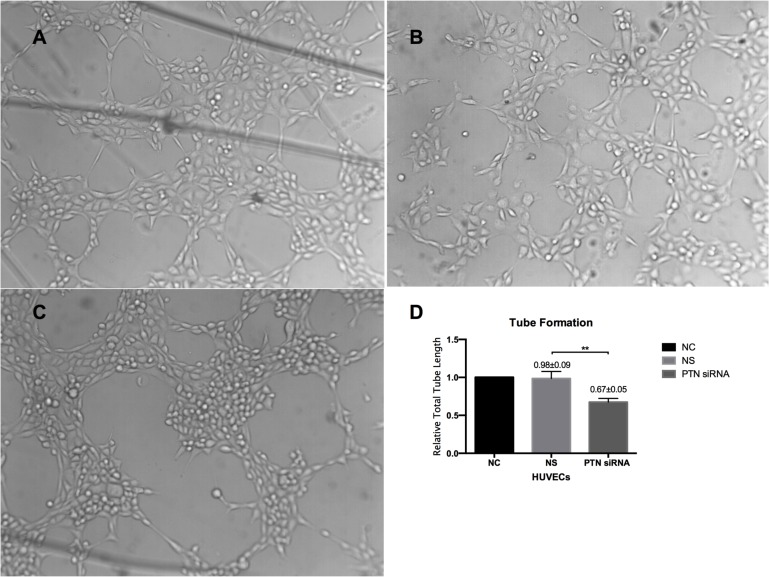
Effects of PTN on HUVEC tube formation.Microphotographs are representative of tube-like structure generation after a 4-h incubation on Matrigel. The length of tube branches per view field was measured. PTN-siRNA-treated HUVECs (panel C) showed an impaired capacity to form a regular vascular network. The length of the angiogenesis network was statistically significantly decreased compared to the control groups. Each experiment was repeated at least three separate times. Data are presented as the means ± SD. NC was set to 100%. **P < 0.01.